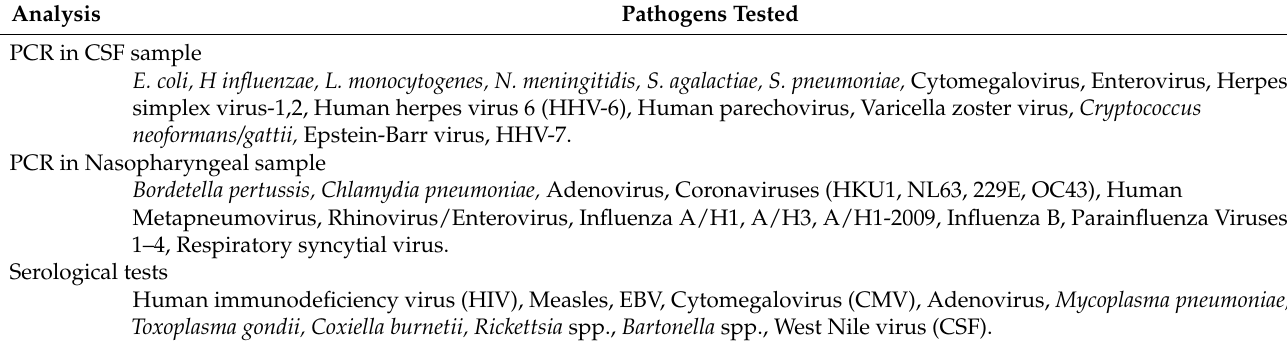
Table 1. Microbiological analyses performed in the encephalitis